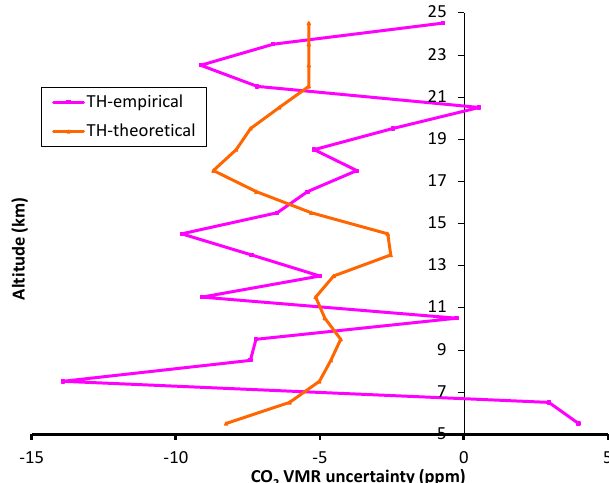
Figure 6. CO 2 VMR uncertainty versus altitude due to tangent height uncertainty from two different methods. “TH-empirical” propagates the observed TH differences versus those retrieved us- ing the ACE v3.x algorithm, and “TH-theoretical” includes all of the individual sources of TH-related error added in